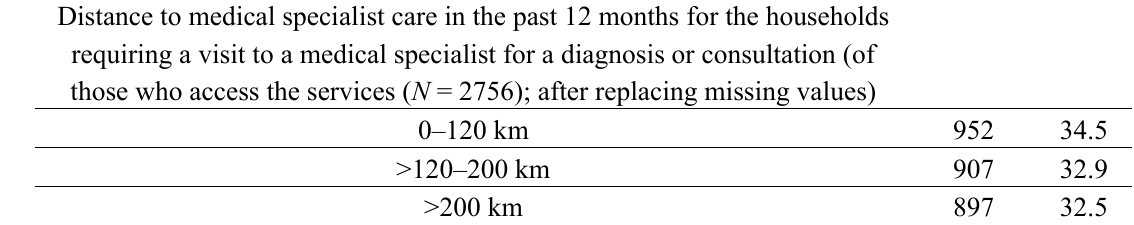
Table 2. Results of log binominal regression analysis examining associations between access to specialist healthcare in the past 12 months and